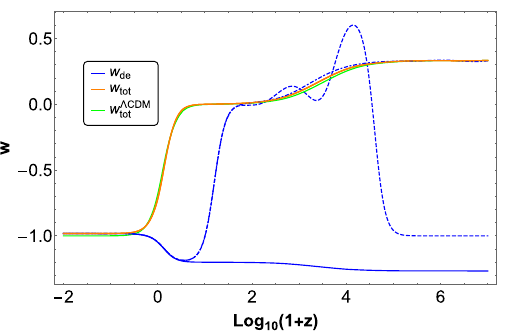
Fig. 4 We depict the evolution of the deceleration parameter q ( z ) as Fig. 2 It is shown the behaviour of the total equation of state w tot a function of the redshift z for the values of parameters s = − 1 . 20, (orange line), the equation of state of dark energy w de (blue line), and σ = 0 . 3 and λ = 150, and the same initial conditions used in Fig. 1. the total equation of state of Λ CDM model (green line) as functions of We have also depicted the corresponding curve for the deceleration the redshift z , for the values of parameters s = − 1 . 20, σ = 0 . 3 and parameter q Λ CDM ( z ) of the Λ CDM model. It is observed that in all λ = 150. Also, for solid, dashed, and dot-dashed blue lines we have the cases the cosmological deceleration-acceleration transition redshift the same initial conditions of Fig. 1. It is observed the phantom value happens at z ≈ 0 . 65, very close to Λ CDM value and consistent with w ≈ − 1 . 05 at the current time z = 0, which is consistent with the de ( 0 ) current observational data [7] = − 1 . 028 ± 0 . 032, from Planck data [7] observational constraint w de